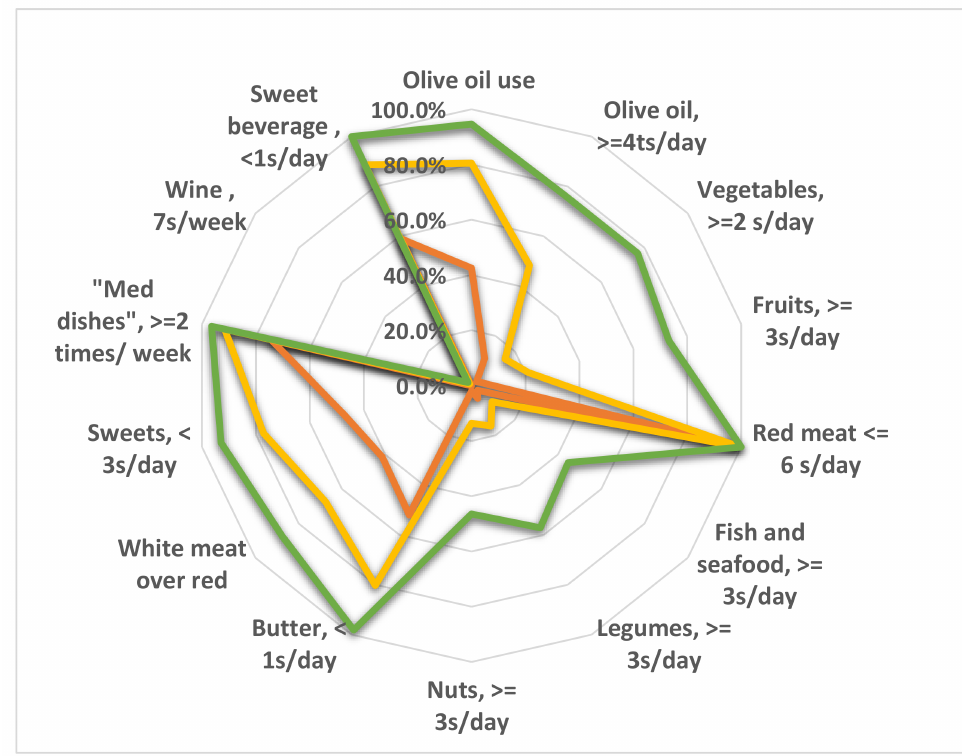
Figure 4. Compliance with items from PREDIMED questionnaire according to adherence profile: high (green), medium (yellow) and low adherence (red) to the Mediterranean diet (MD). The radar chart plots the values of each item of the questionnaire along a separate axis. Each axis refers to one of the 14 recommendations of PREDIMED questionnaire. Axis starts in the center of the chart (0% compliance) and ends at the outer ring (100% compliance). The values are the percentage of respondents compliant with each recommendation. The figure shows that consumption of fish and seafood, legumes, nuts and wine are commonly inappropriate for the three MD-adherence